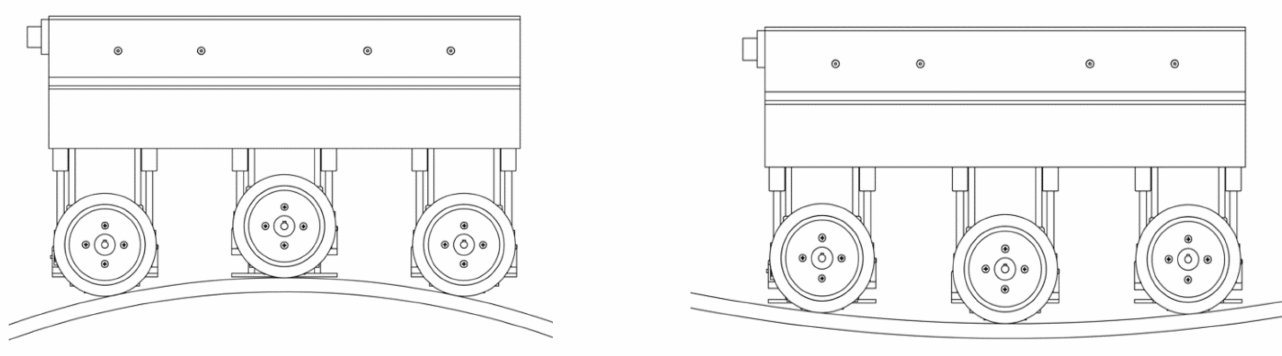
Figure 7. Movement on the ship curved shell